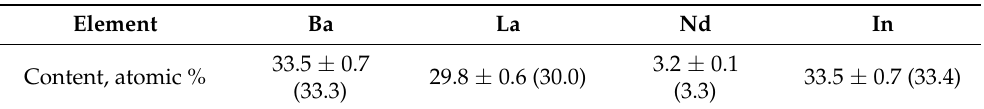
Table 2. The average element ratios determined by EDS analysis for the sample BaLa 0.9 Gd 0.1 InO 4 (theoretical values are in